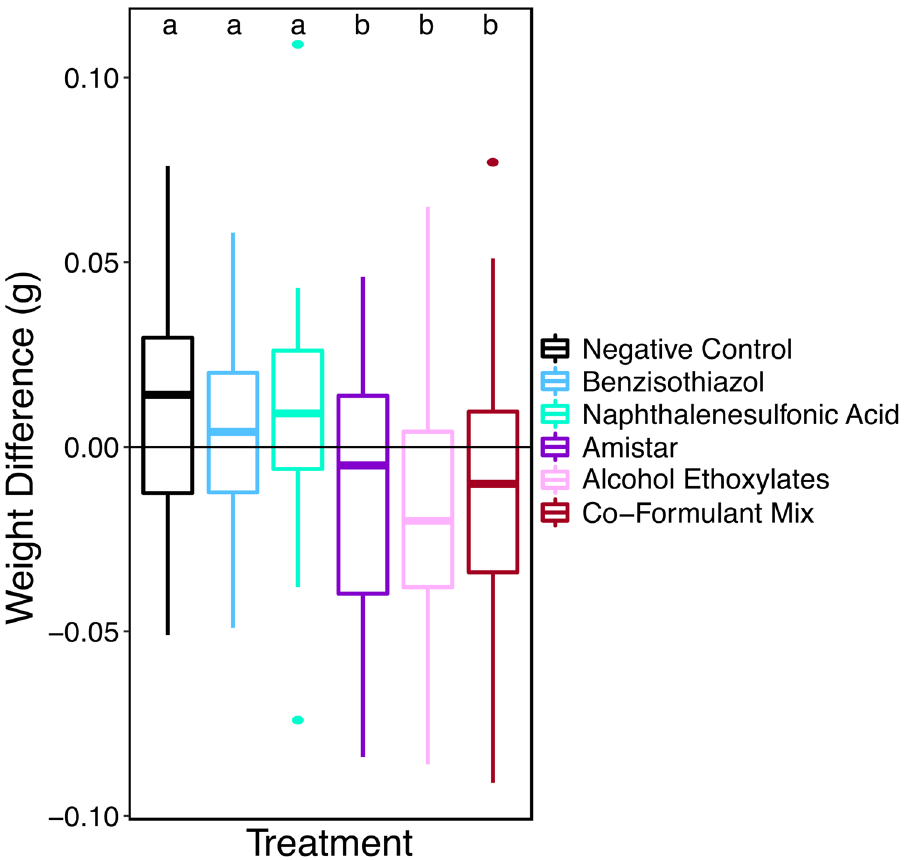
Figure 3. A boxplot showing change in weight over the 120-h period, or until death colour coded by treatment. Boxes represent the Inter-Quartile Range (IQR), with the bold horizontal line the median value. The whiskers represent the furthest datapoint within 1.5 times the IQR and points beyond this are plotted as outliers. Different letters indicate statistically significant